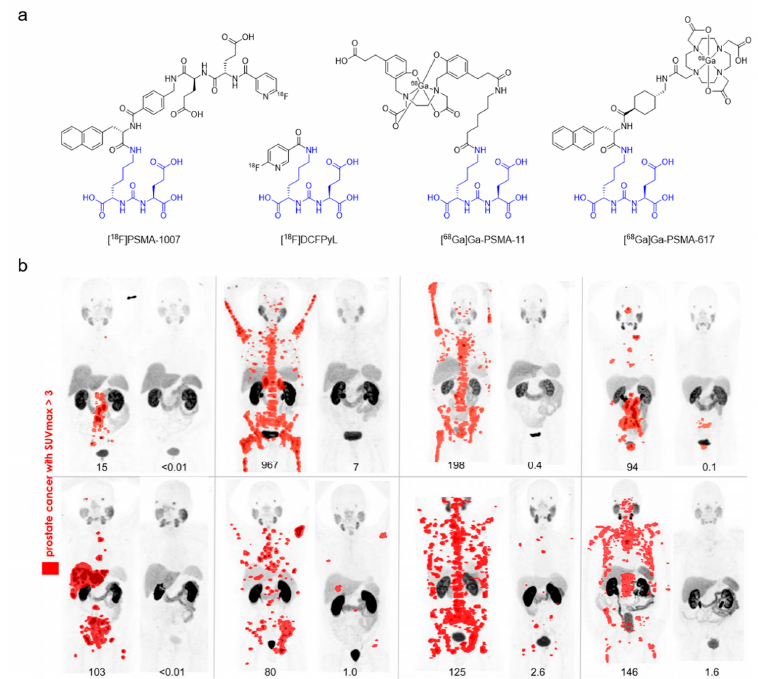
Figure 5. Prostate-specific membrane antigen imaging. ( a ) Chemical structures of several PSMA imaging agents. The four radiopharmaceuticals share a Glu-urea-Lys binding motif (in blue). ( b ) [ 68 Ga]Ga-PSMA-11 PET maximum intensity projection (MIP) images at baseline and 3 months after [ 177 Lu]Lu-PSMA-617 treatment in eight patients with PSA decline of ≥ 98% in a prospective phase II study. Lesions with standardized uptake value (SUV) over three are highlighted in red. PSA values (ng/mL) are indicated below MIP images. Figure reproduced with permission from J. Nucl. Med. 2019 , jnumed.119.236414 [93]. Copyright 2019 Society of Nuclear Medicine and Molecular Imaging.